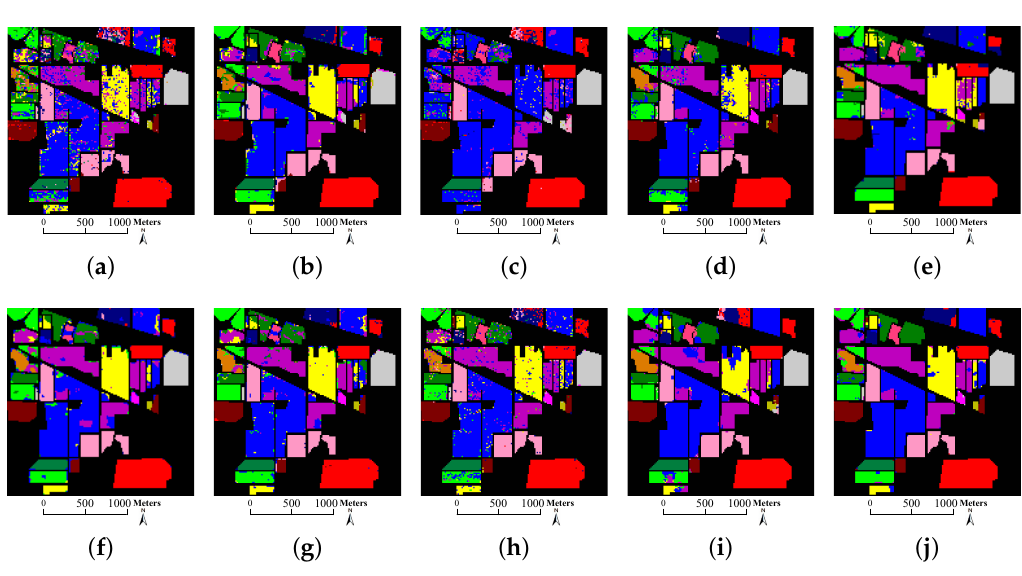
Figure 10. Classification maps of the Indian Pines data obtained by ( a ) SVM; ( b ) SVMCK; ( c ) CRC; ( d ) SOMP; ( e ) SADL; ( f ) 3D-DWT; ( g ) LTDA; ( h ) cdSRC; ( i ) pLSRC; and ( j )